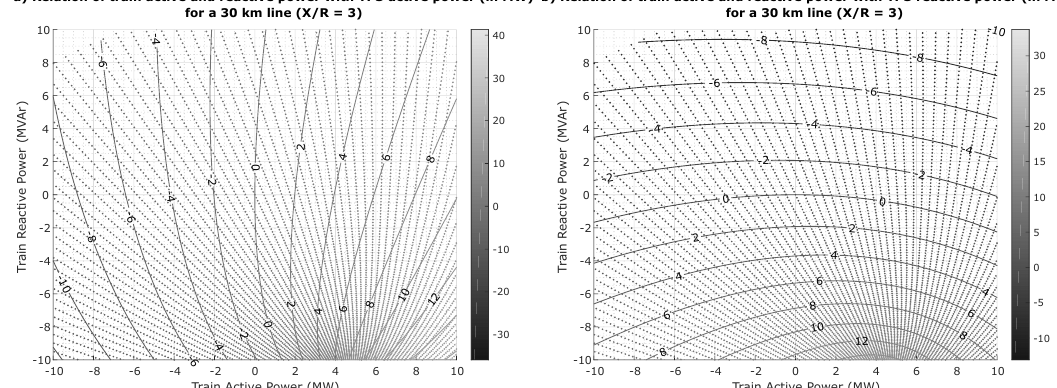
Figure 3. Sensibility analysis for different conditions of train power: ( a ) active power flow at TPS; ( b ) reactive power flow at TPS.